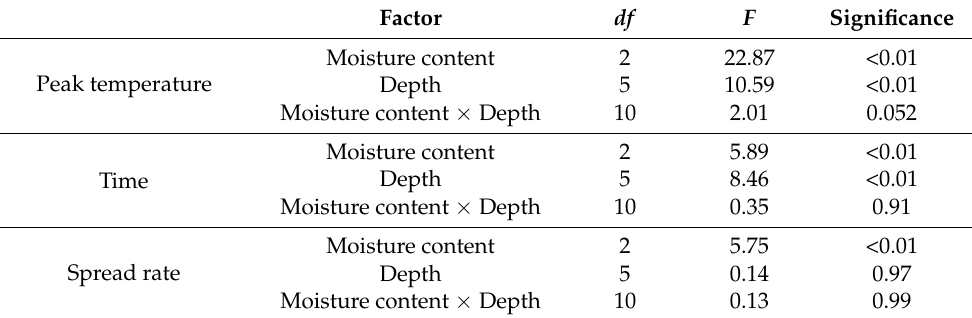
Table 1. Variance test on the influence of humus moisture content and depth on smoldering charac- teristics during sub-surface